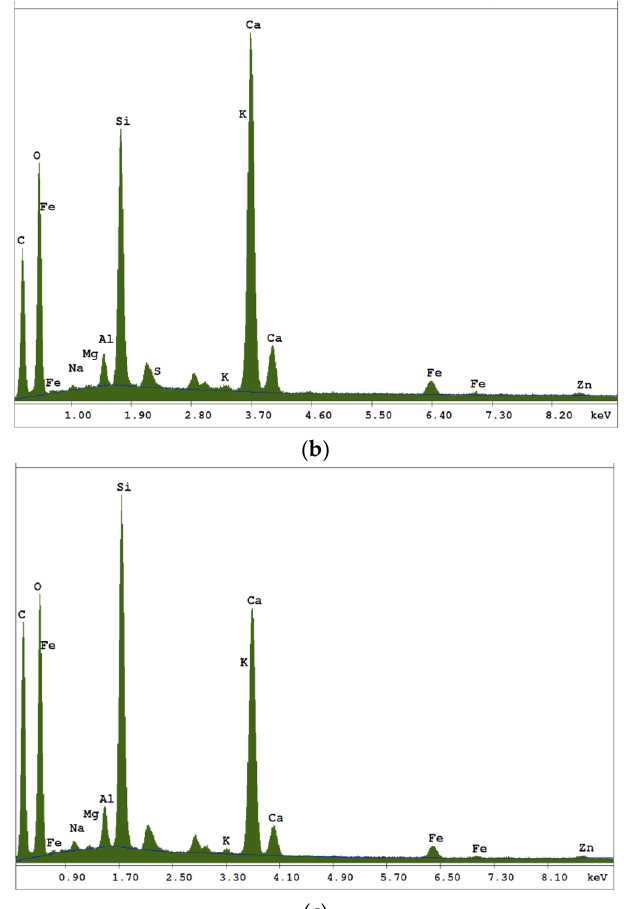
Figure 7. Composition analysis (EDS) of tested boards: ( a ) matrix, ( b ) fibre of air-dry condition (reference board) and ( c ) “fibre” of board exposure to temperature of 230 ◦ C-3 h.